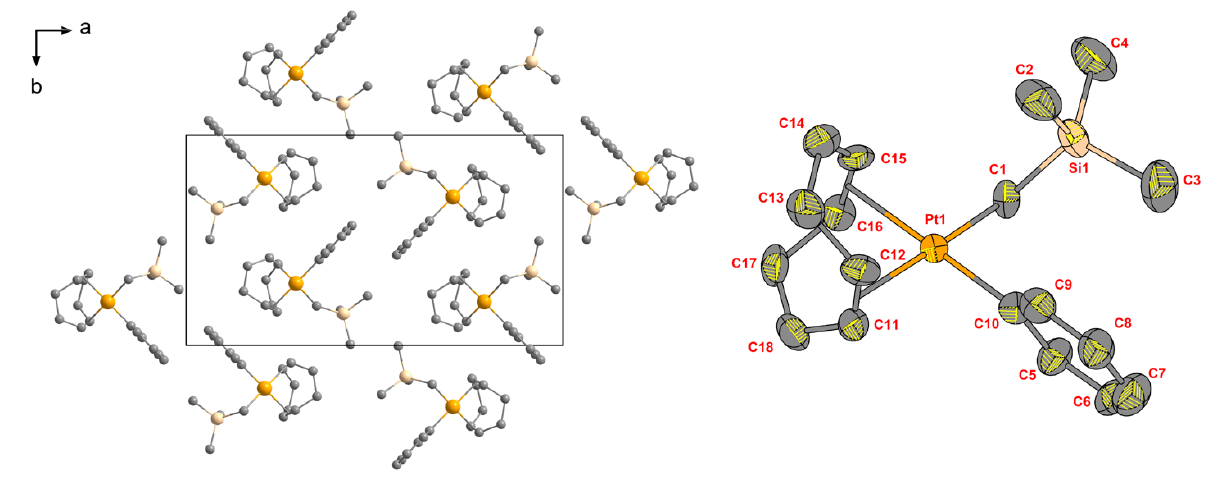
) along the crystallographic c axis. Right: Molecular structure Figure 6: Left: View on the unit cell of [Pt(cod)(neoSi)(Ph)] (orthorhombic P na2 1 of [Pt(cod)(neoSi)(Ph)]. Atoms shown as ellipsoids at 50% probability, H atoms are omitted for clarity. Important distances and angles: Pt(1)– C(1) = 2.000(9) Å, Pt(1)–C(10) = 2.045(9) Å, Pt(1)–X(A) = 2.105(1) Å, Pt(1)–X(B) = 2.120(1) Å; X(B)–Pt(1)–C(10) = 179.7(3)°, C(1)–Pt(1)–C(10) = 88.0(3)°, C(1)–Pt(1)–X(A) = 178.2(2)°, X(B)–Pt(1)–X(A) = 86.1(2)°, with X(A) being the centroid of the C(11)=C(12) bond and X(B) the centroid of the C(15=C(16) bond. Sum of angles around Pt =